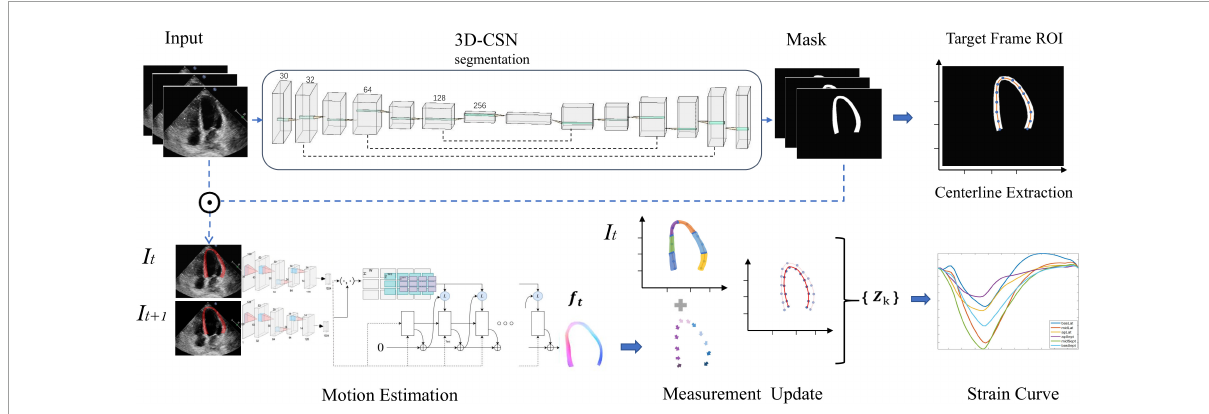
FIGURE1 Overview of the deep learning (DL) workflow for automatic measurement of longitudinal strain. 3D-CSN uses multi-frame echocardiogram images as input to delineate the region of interest and segments, and extract the centerline of target frame. Then, the motion network estimates the movement field of the pixels in the ROI to generate the velocity vector at each moment. These velocities are used to propagate the position of the centerline and then calculate the global and local line arc lengths coexisting in {Zk} which are used as a basis for strain